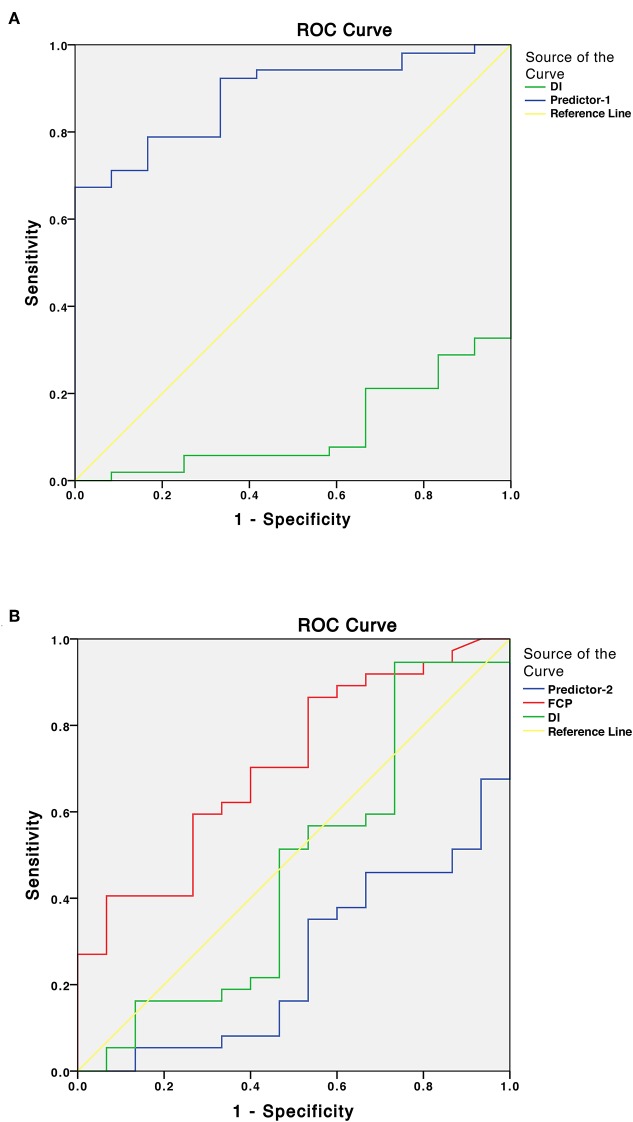
(A) Receiver operating characteristic (ROC) curves of the disposition index (DI) and Predictor-1 for predicting glucose intolerance (DM/IFG/IGT) before surgery. Predictor is the predicted value calculated by the prediction model using logistic regression analysis. (B) ROC curves of the fasting C-peptide (FCP), DI and Predictor-2 for predicting improved glucose tolerance status after surgery.